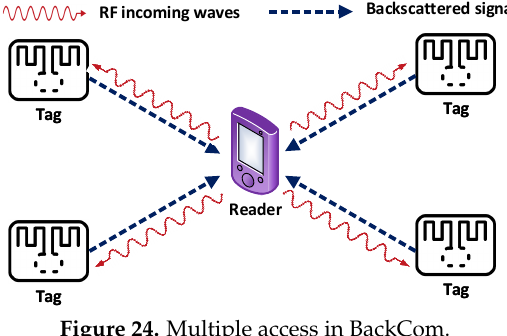
Figure 24. Multiple access in BackCom.